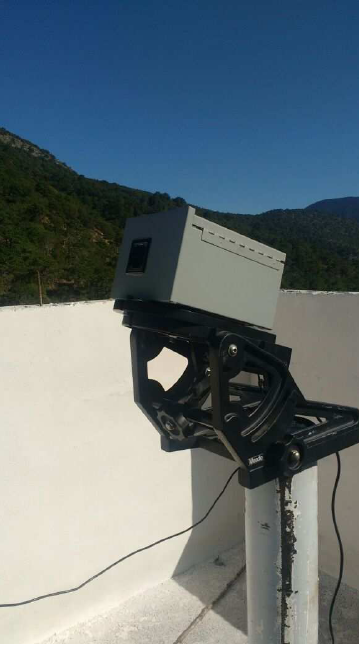
Figure 7. DIMM camera device for seeing measurements, currently installed at the UANL Solar Observatory.